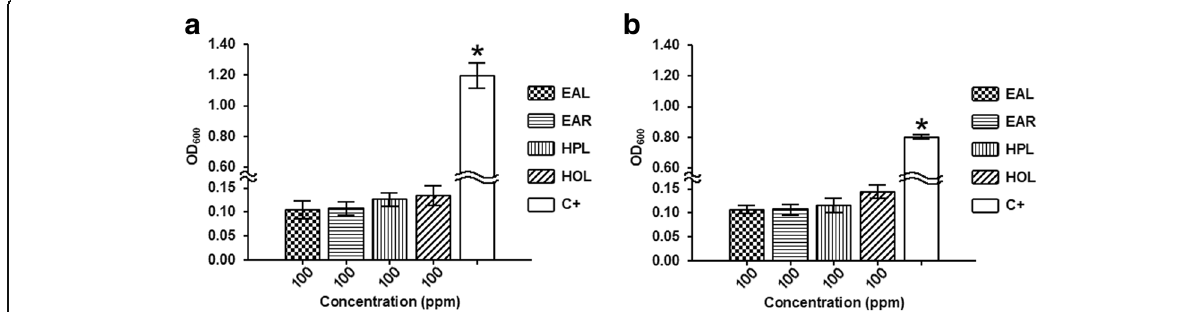
Fig. 3 E. coli ( a ) and C. albicans ( b ) planktonic growth without (positive control) and with each seagrass extract at 100 ppm. The positive control was set up with mineral medium supplemented with glucose at 5 g/l. Stars indicate statistically significant differences (Tukey ’ s HSD, p ≤ 0.05) between the means of three independent replicates. (EAL = Enhalus acoroides leaf; EAR = Enhalus acoroides root; HPL = Halodule pinifolia leaf; HOL = Halophila ovalis leaf; C + = Positive control)